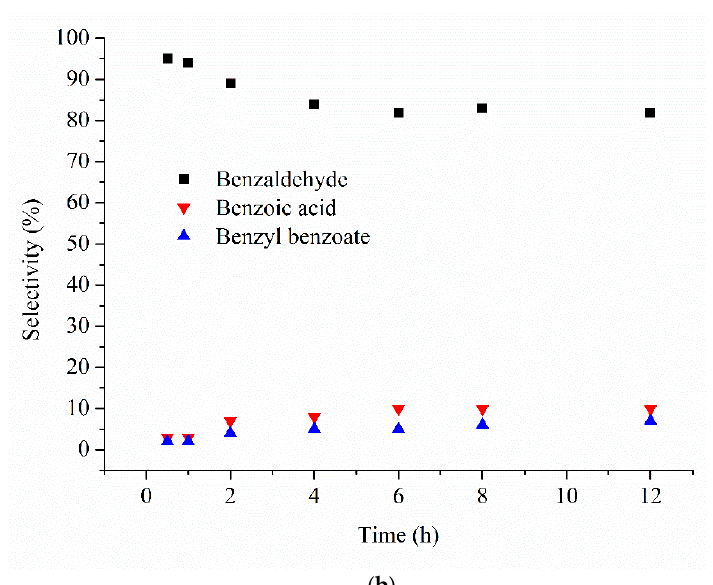
Figure 2. Products distribution for ( a ) 1% Au IW /VPO and ( b ) 1% Au IW /AC